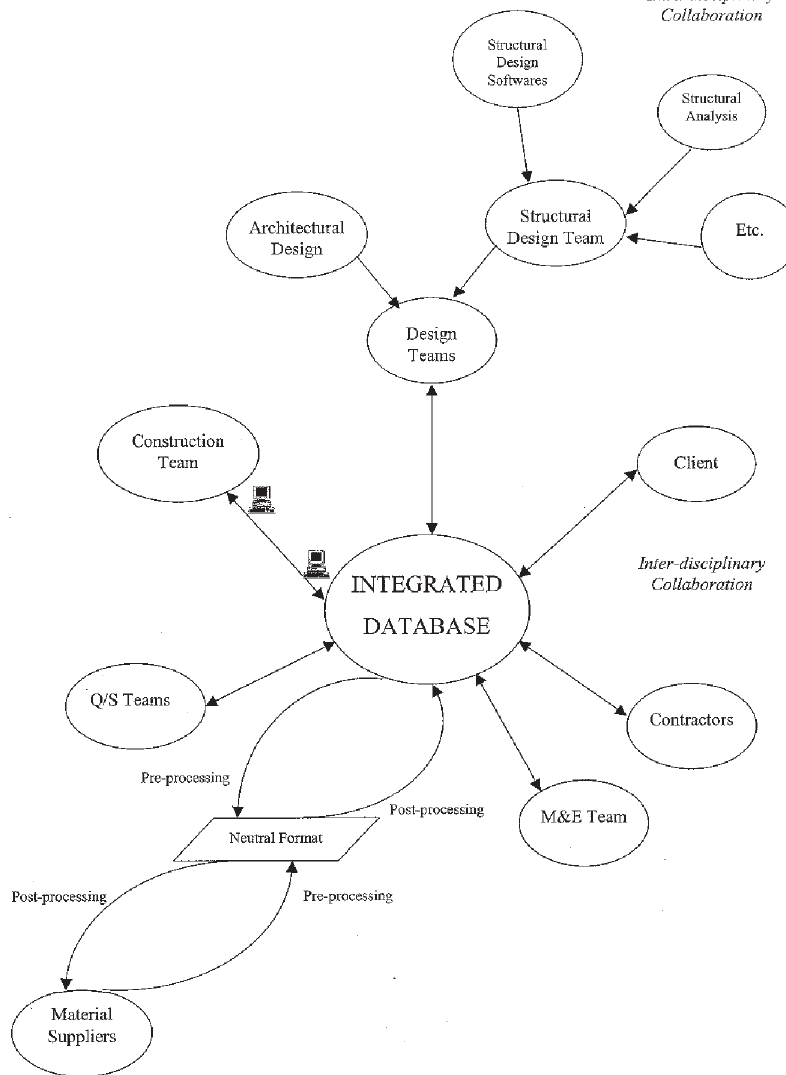
Figure 4: Integrated database model for the construction